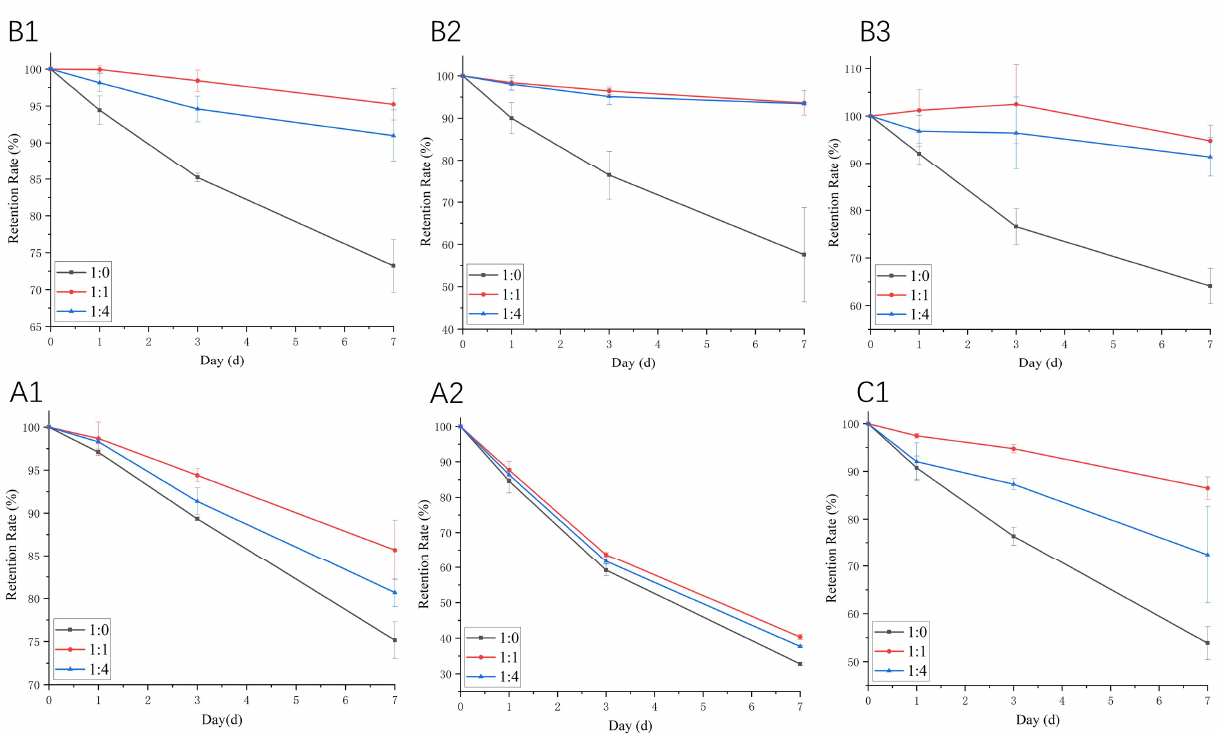
Figure 9. The storage stability of proanthocyanidin A1, A2, B1, B2, B3, and C1 with WPI at room temperature. The molar ratios of proanthocyanidin:WP are 1:0, 1:1, and 1:4,